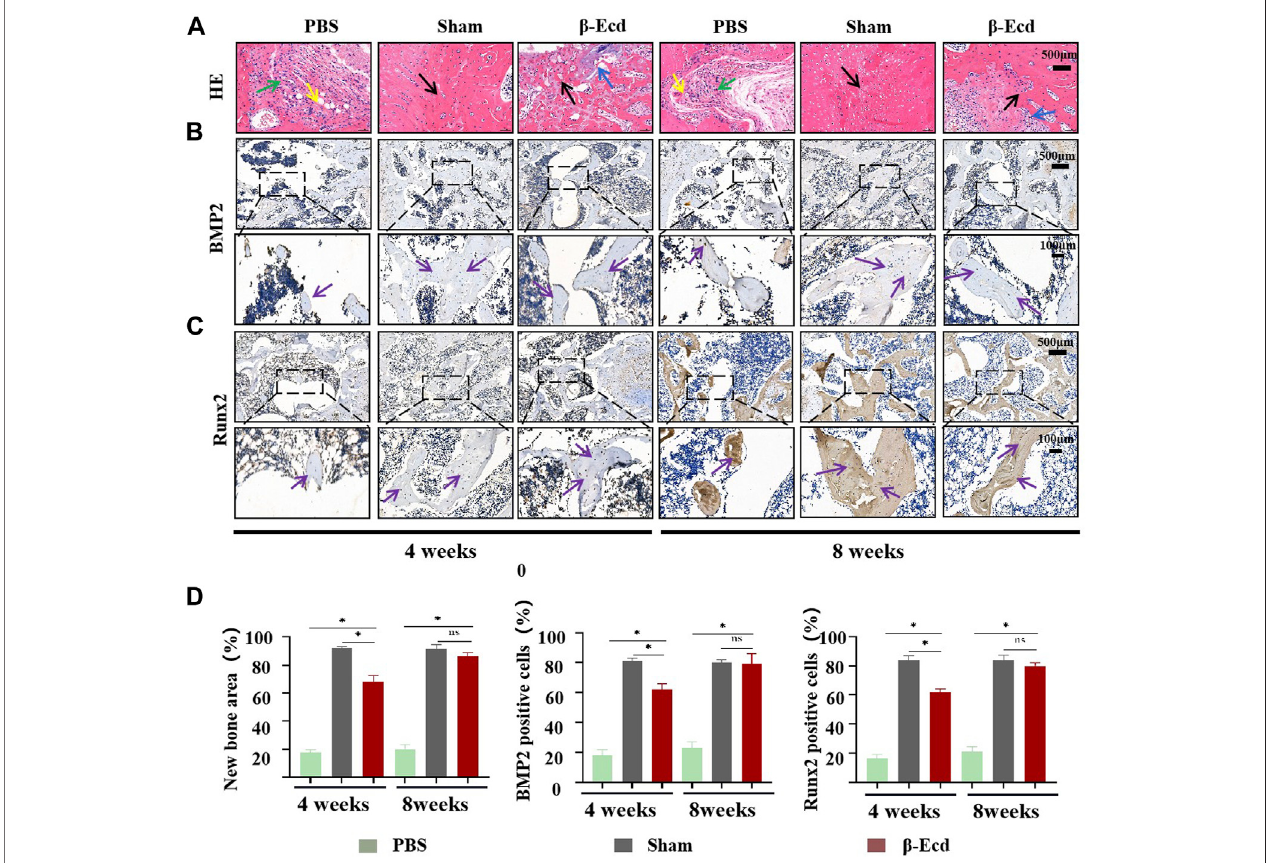
FIGURE7| Histomorphological analysisofnewlyformed bone tissue inbone defect area and immunohistochemicalevaluationofosteogenesis-related proteinsin newlyformedbone. (A) HEstainingofbonetissuesectionsaroundthebonedefectat4and8 weeks;Greenarrow: fi broustissue;Yellowarrow:newcapillaryformation; Black arrow: bone tissue. (B,C) immunohistochemical detection of the expression of the BMP2/Runx2 protein in the new tissue in the area of the bone defect, the enlarged images in the black box are bone trabeculae or osteocytes; (D) The area of new bone tissue and the expression of the BMP2 protein in the three groups were statistically analyzed using ImageJ software. At 4 weeks, the expression of the BMP2/Runx2 protein was signi fi cantly increased in the bone defect area; At 8 weeks,theexpressionoftheBMP2/Runx2proteinwassigni fi cantlyincreasedinthebonedefectarea,buttherewasnosigni fi cantdifferencebetweenthe β -Ecdgroup and the sham-operated group. Each group contained three replicates, and the data were analyzed by one-way ANOVA for multiple comparisons. Purple arrow: BMP2/ Runx2 protein positive site. *p < 0.05, ns, not signi fi cant.